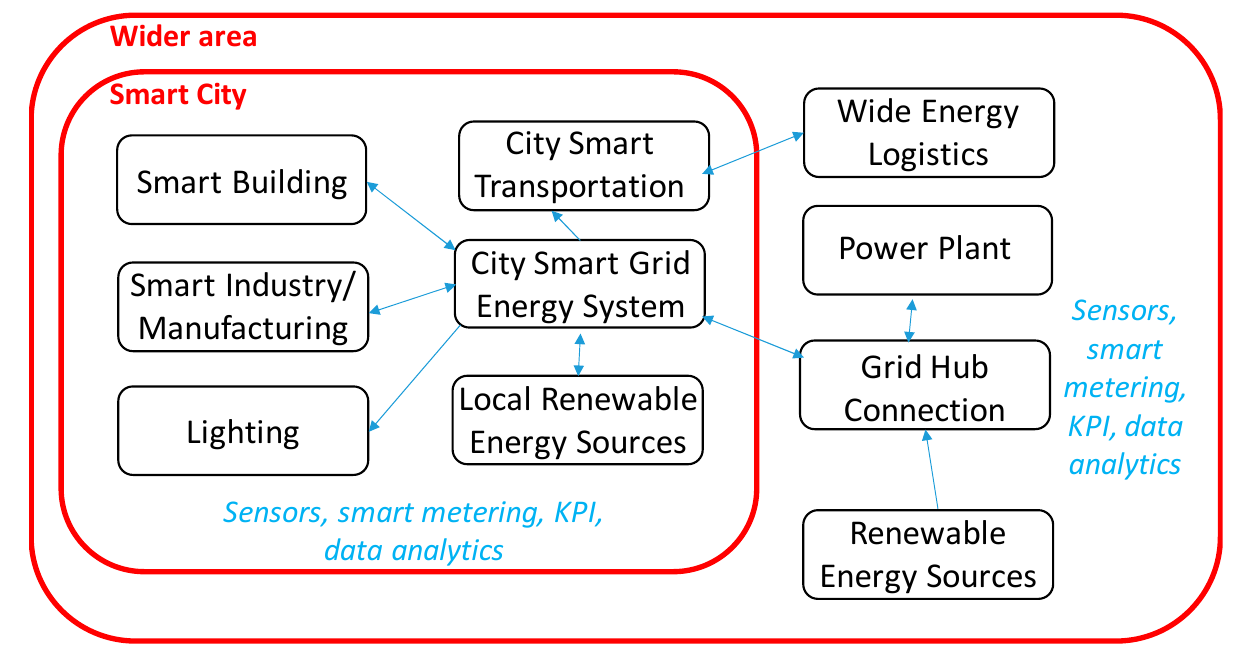
Figure 1. Architecture of an energy monitoring scaled system.